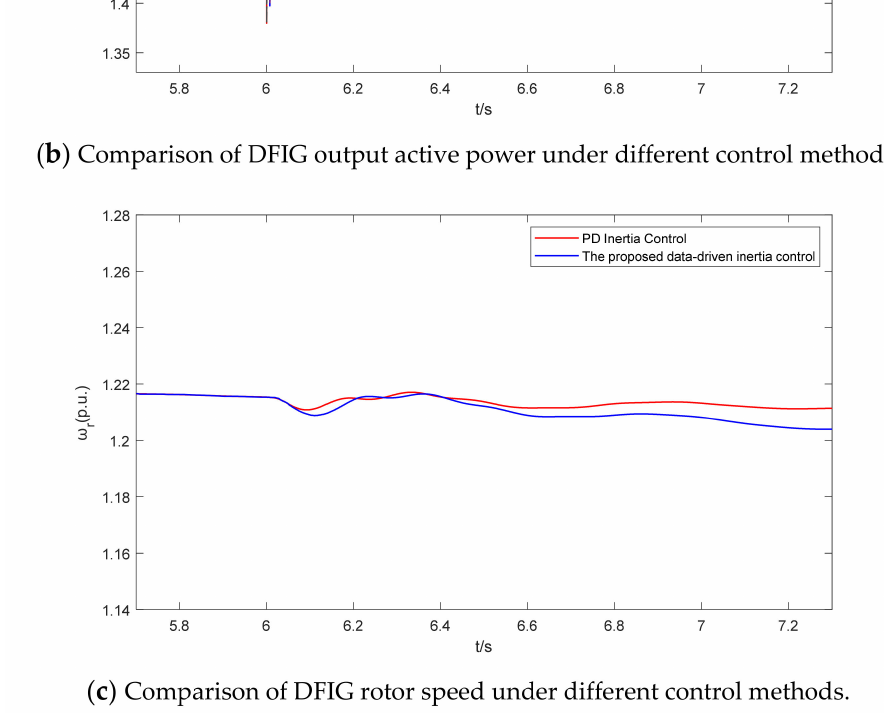
Figure 8. Simulation results of power system when frequency decreased with measurement